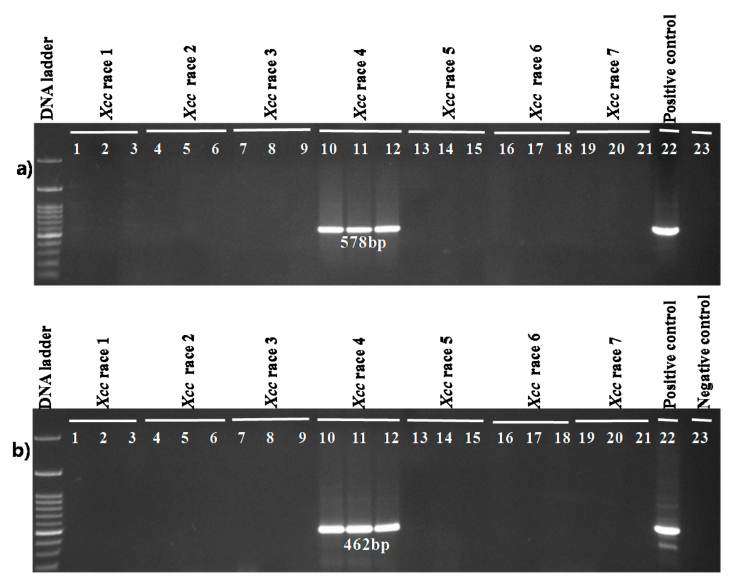
Figure 6. Bio-PCR detection of Xcc race 4 in cabbage leaves shown using two race 4 specific markers ( a ) Xcc1_46R4 and ( b ) Xcc2_46R4; bp; Lanes 1–21: Three inoculated leaf samples against each of seven Xcc races (race 1–7); Lane 22: genomic DNA (race 4, HRIW-1279A) and Lane 23: Negative control